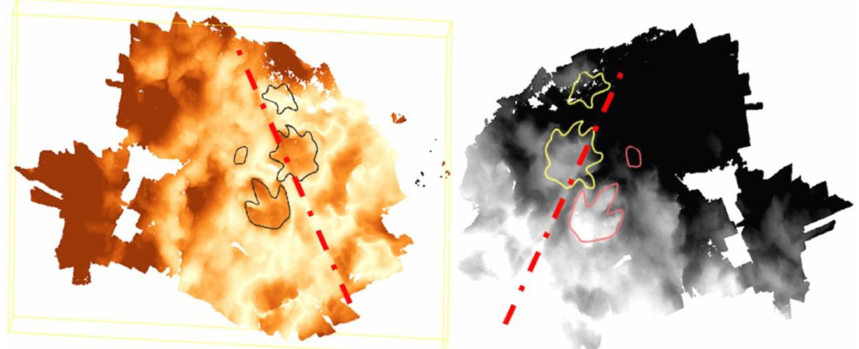
Figure 7. The same images shown in Fig. 6 but the natural color of the images has been replaced by colors that vary with depth. The dashed red line shows the location of a fracture in the rocks, and the footprints are outlined in this image.